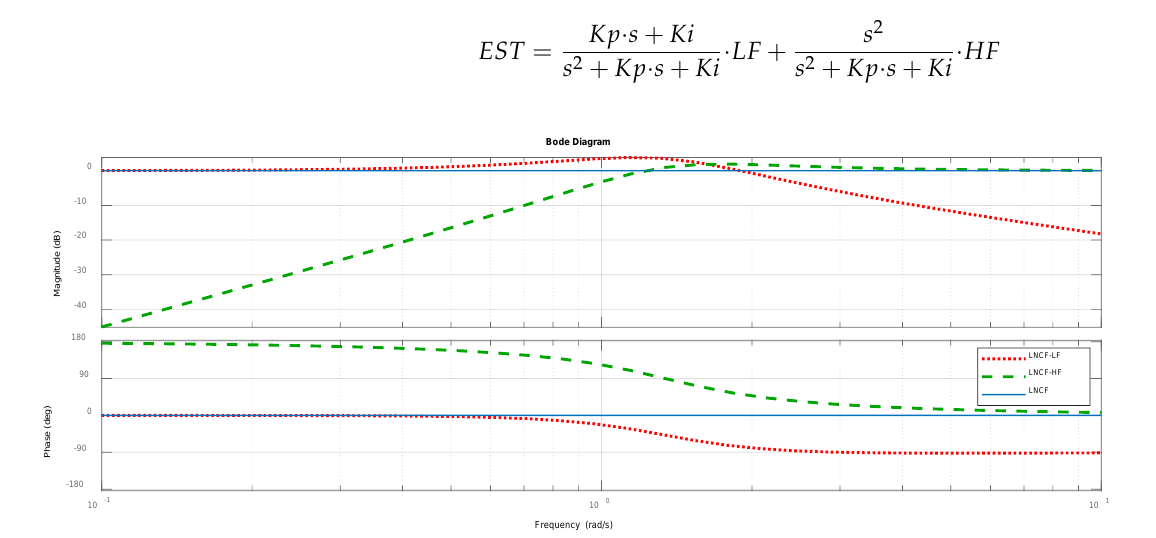
Figure 4. Non-linear complementary filter diagram. The non-linear CF (NCF) is based on the proportional–integral controller, in which the proportional part manages the low-frequency input and the integral part handles the high- frequency signal. K p and K i indicate the proportional and integral gain, respectively [27]. The non-linear complementary filter transfer function is represented by Equation (14). The amplitude and phase shift of the NCF is presented in Figure 5.